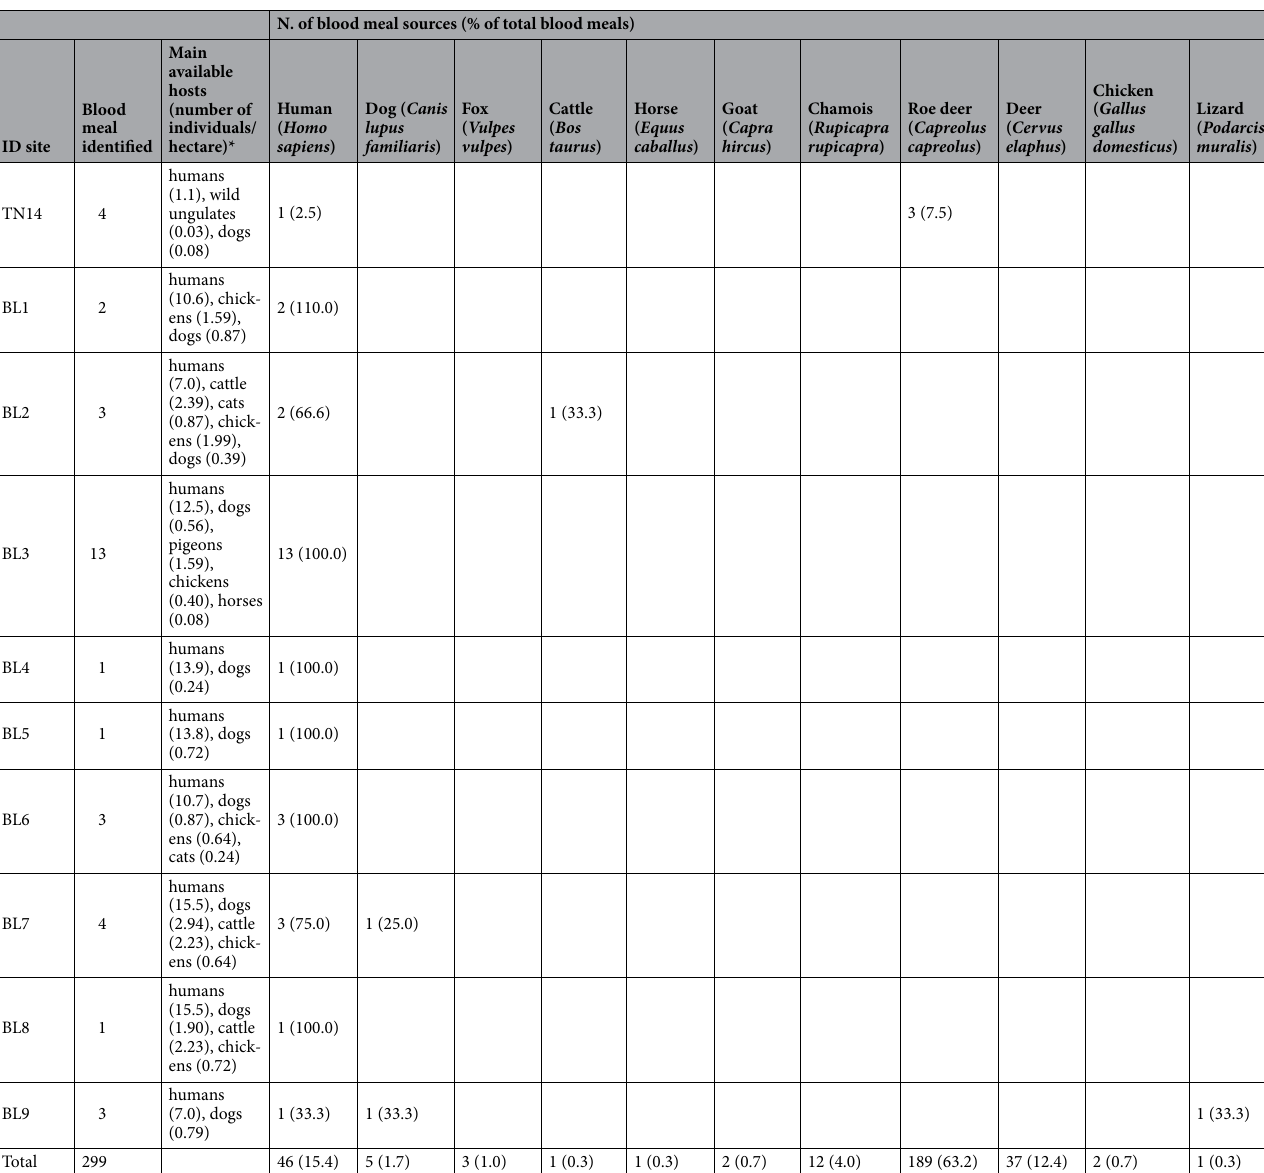
Coefficient Estimate Standard Error p